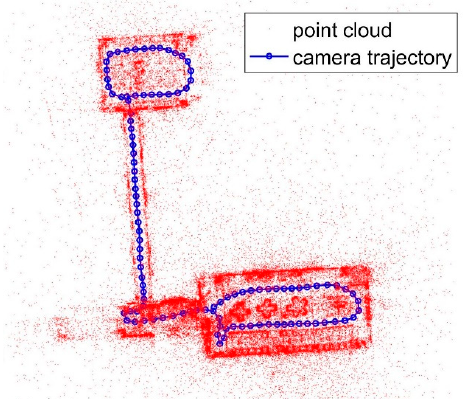
Figure 3. Point cloud from multi-view forward intersection.